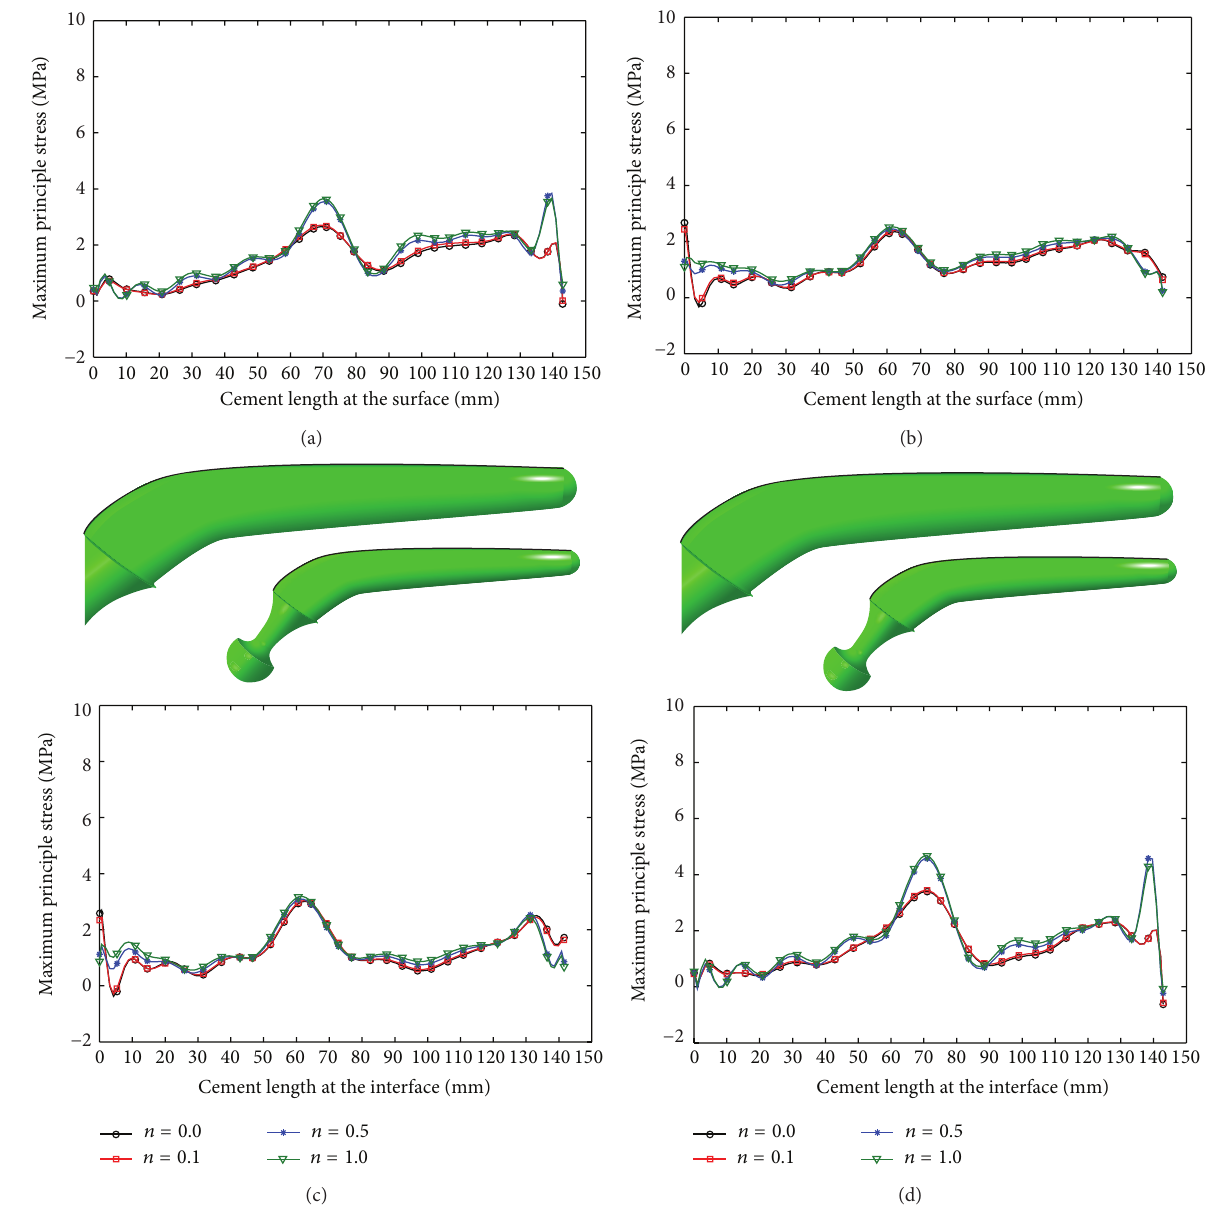
Figure 12: Maximum principal stress variation in cement layer due to radial prosthesis: (a) normal walking, internal surface, (b) normal walking, external surface, (c) stair climbing, internal surface, and (d) stair climbing, external